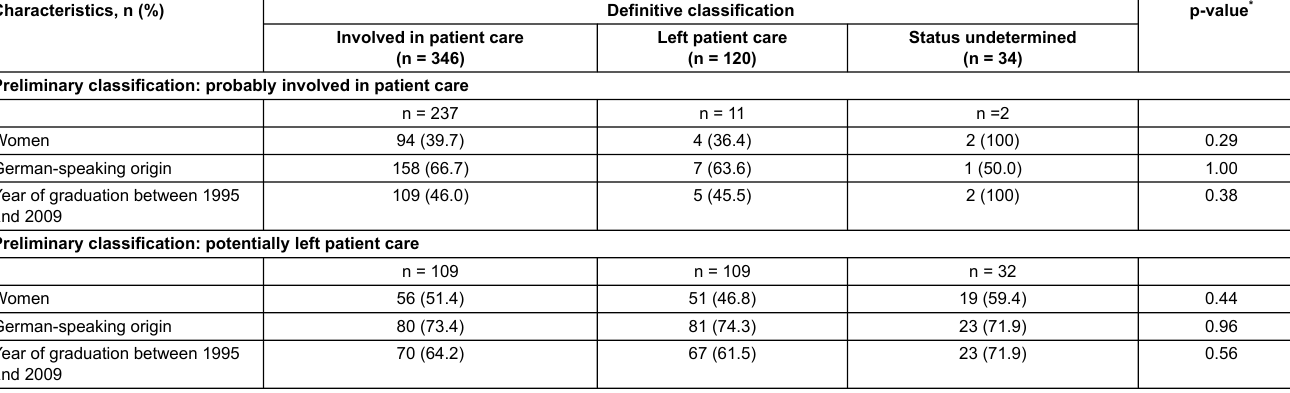
Table 1: Cross-tabulation of baseline characteristics with the definitive classification of physicians stratified by the preliminary classification. Characteristics, n (%)